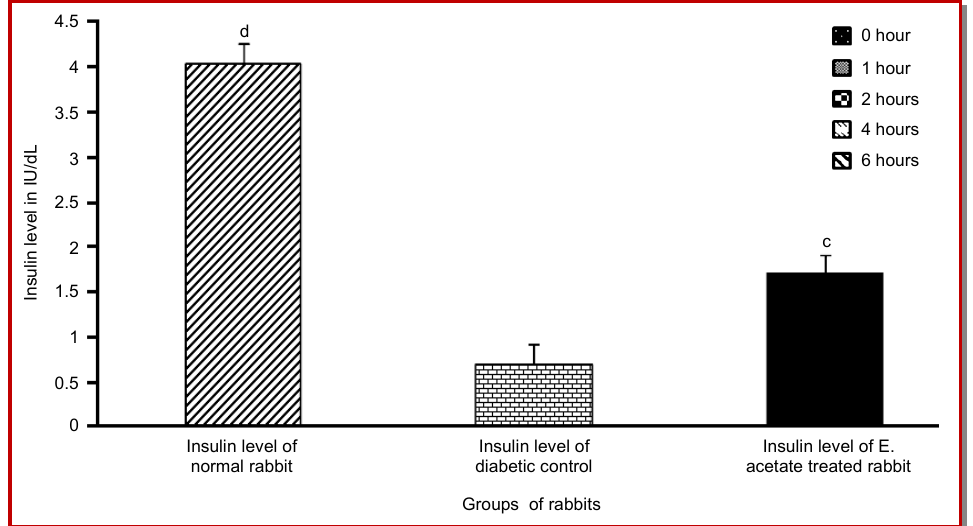
Figure 6: The effect of ethyl acetate extracts of on serum insulin level of diabetic rabbits 30 day, c p<0.001; d p<0.0001 significant increase as compared to diabetic